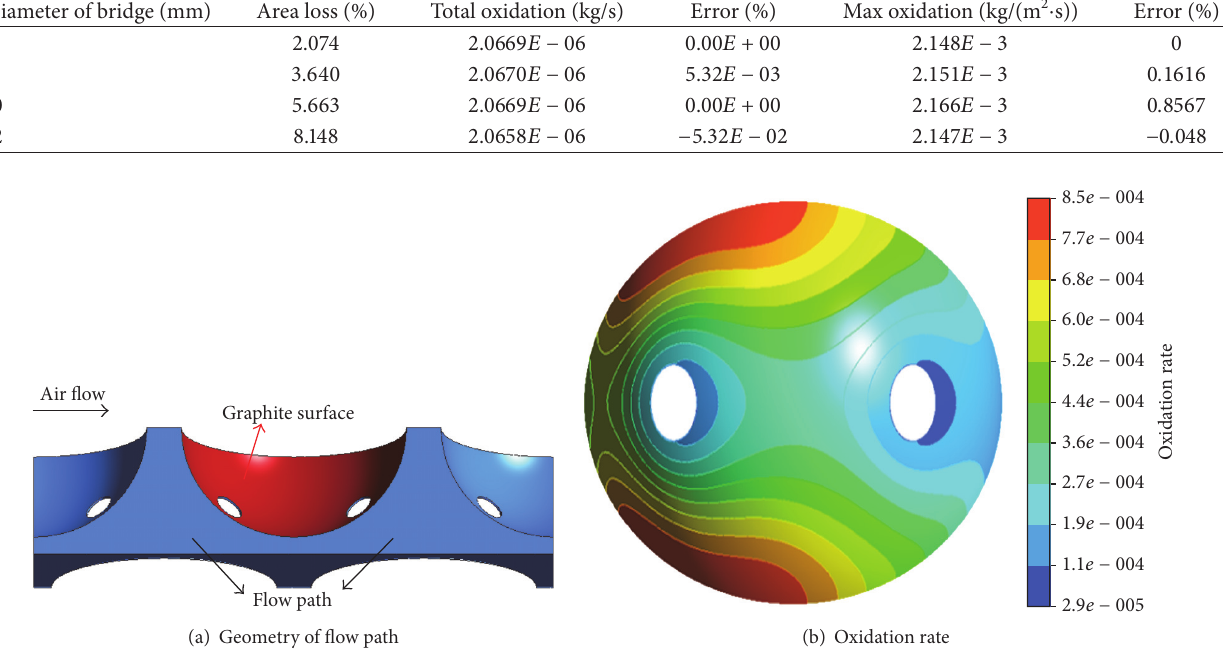
Figure 4: Oxidation distribution on the graphite sphere